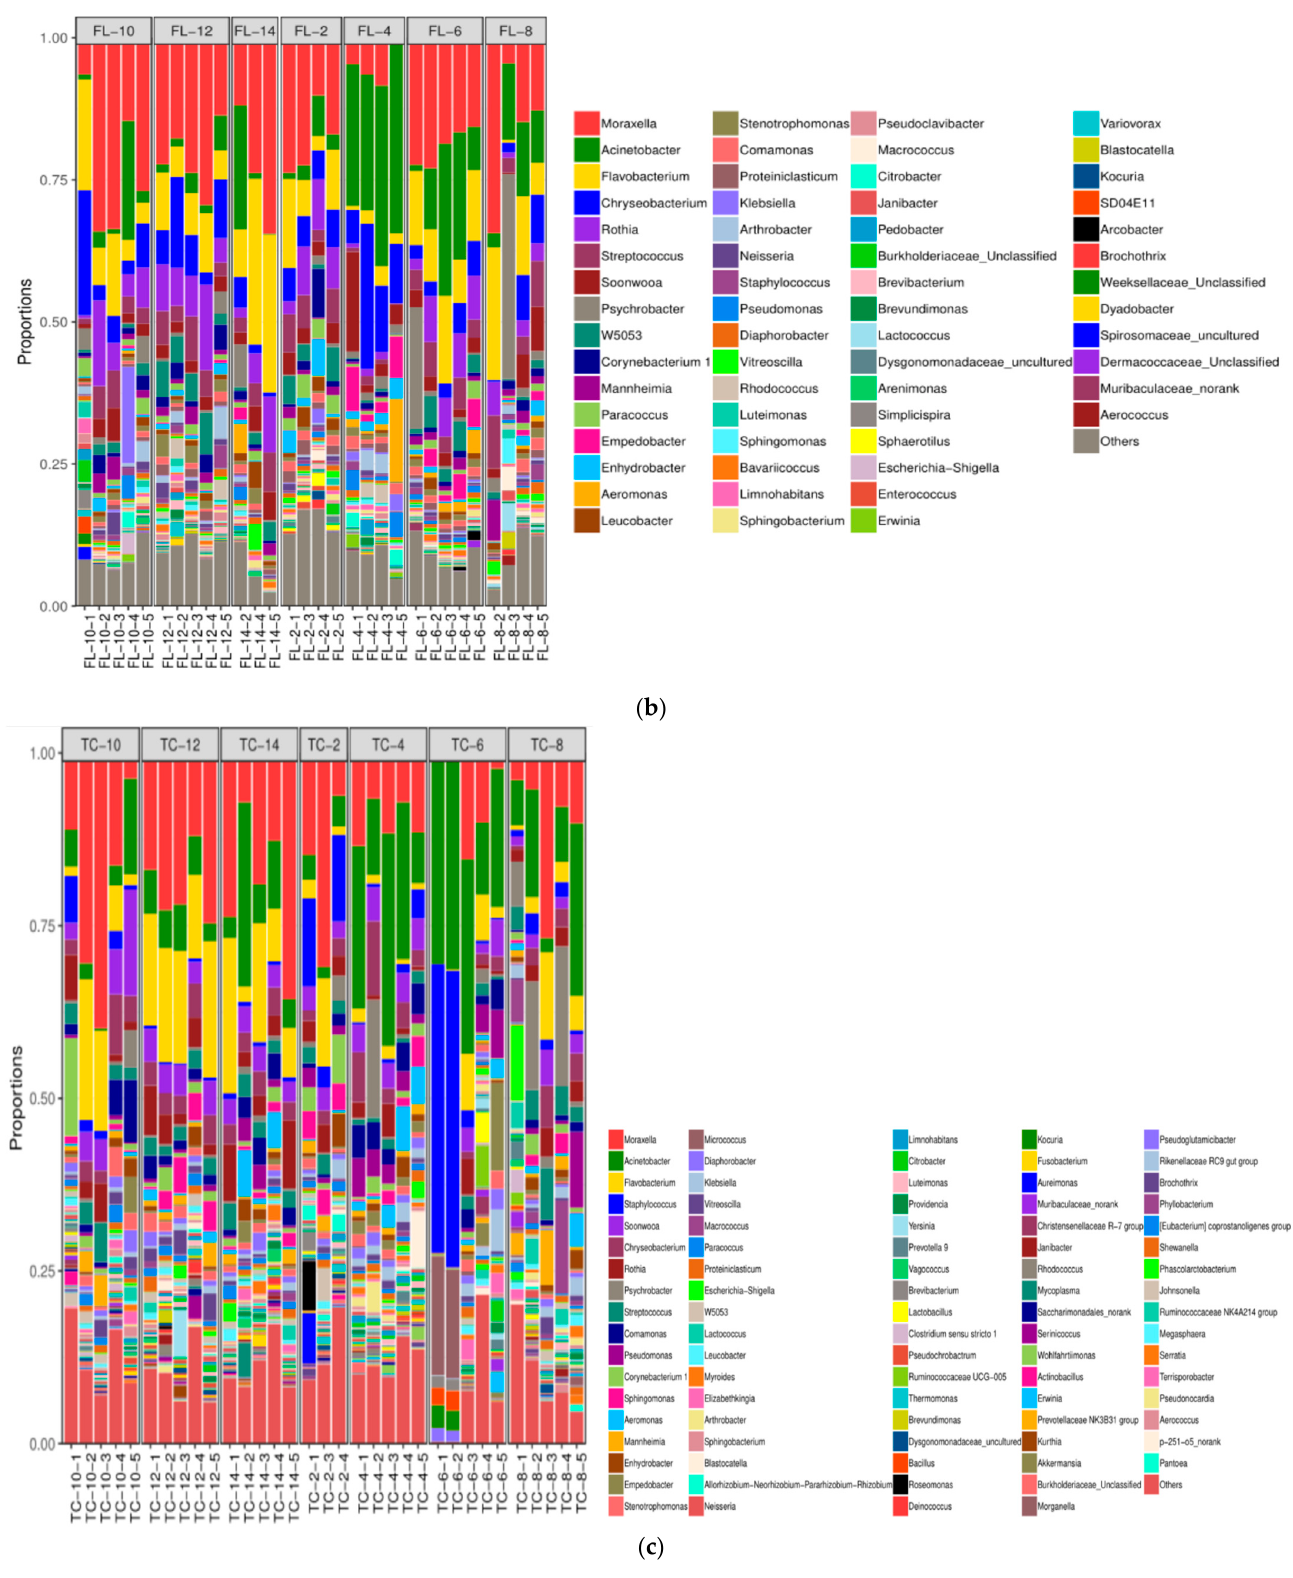
Figure 7. Community structure components of air ( a ), foreleg ( b ), and thorax ( c ) microorganisms at the genus level.